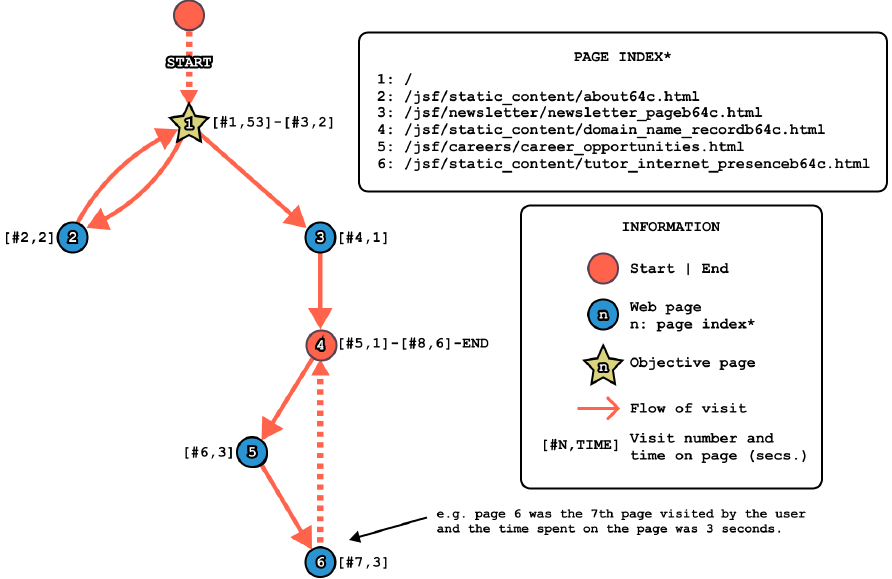
Figure 9. Click Path. Navigation graph of a visit. The number at the edge’s center indicates the view step, and the one with a clock icon shows how long the previous page was